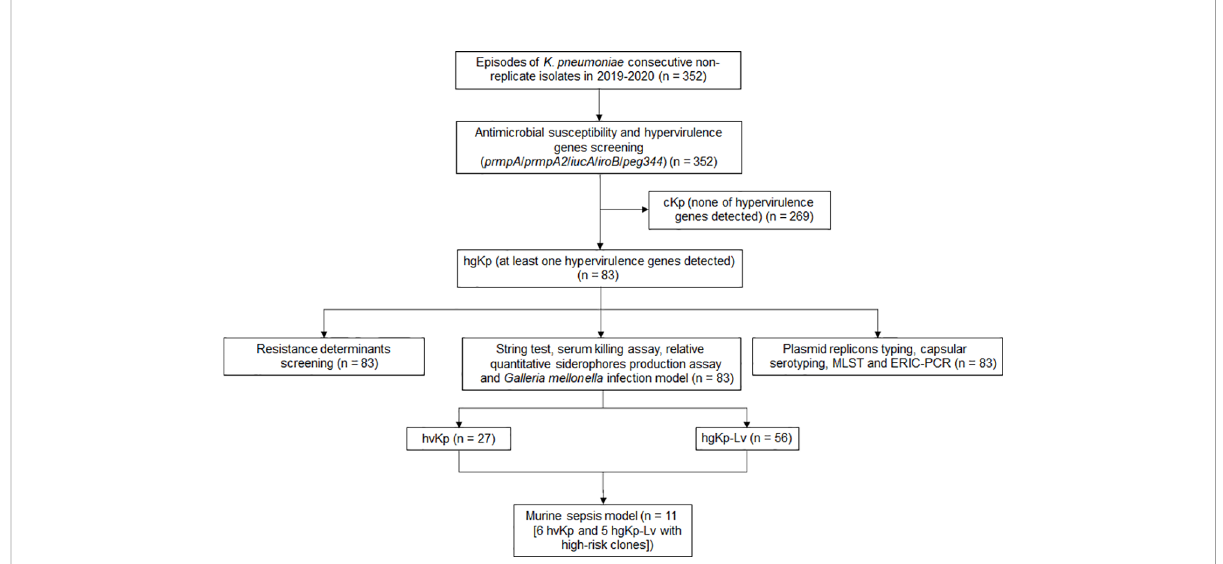
FIGURE 1 Flowchart for screening hypervirulent K. pneumoniae (hvKp) in this study. HgKp, hypervirulence genes-positive K. pneumoniae ; hgKp-Lv, hgKp- low